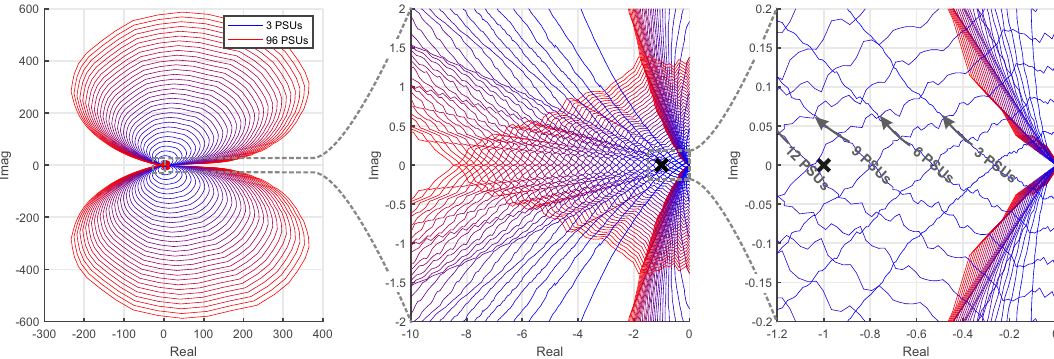
Figure 12. Nyquist contour of the minor loop gain when the number of paralleled PSUs is